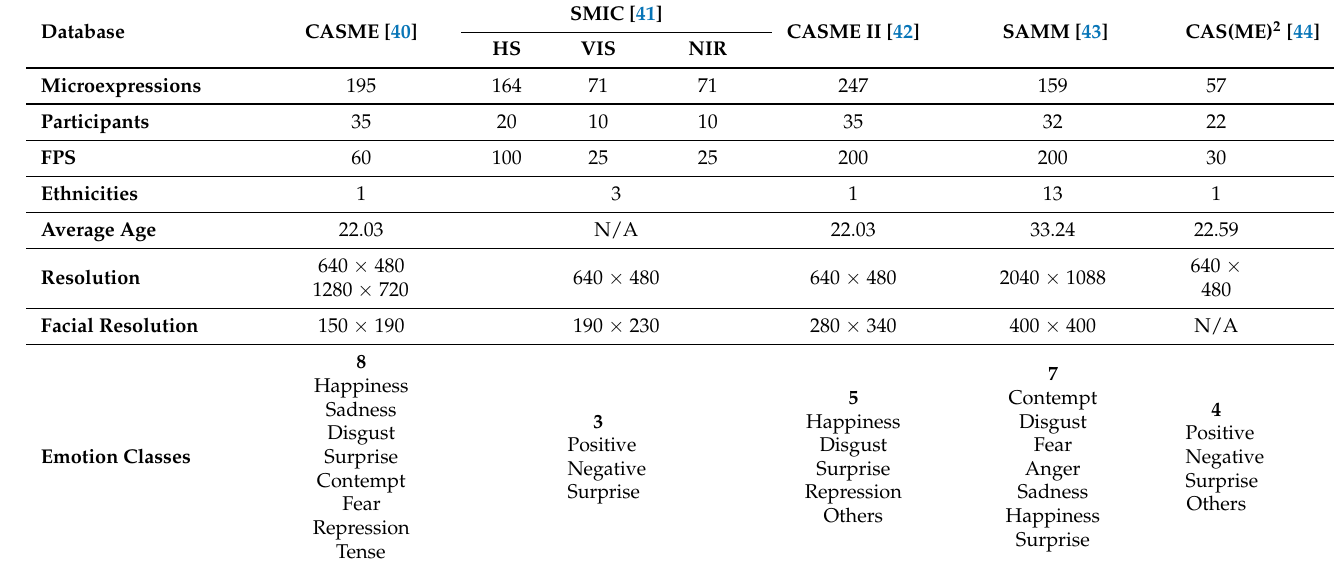
Table 1. Summary of Spontaneous Microexpression